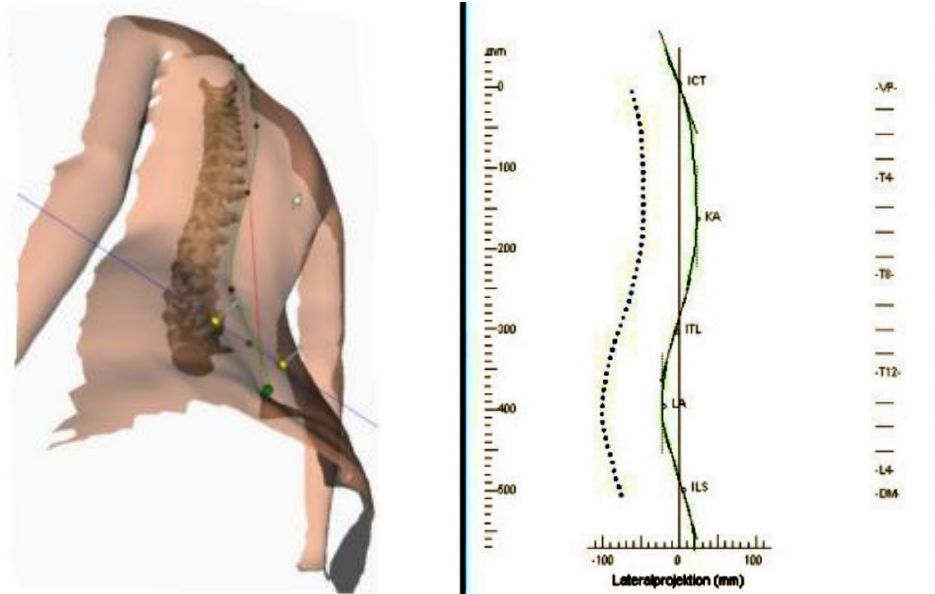
Figure 1. ICT or VP = vertebra prominence, KA = Kyphotic Apex, LA = Lordotic Apex, DM = Dimple Middle.